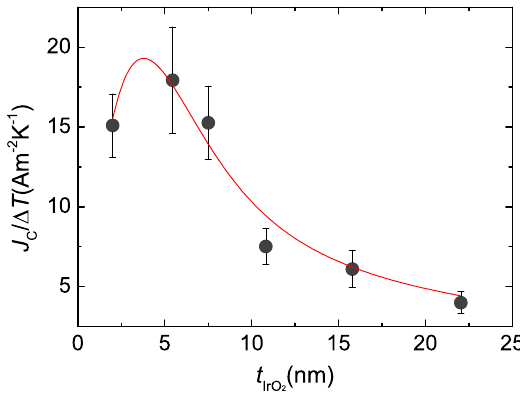
Figure 3. Symbols: ISHE current density normalized by the thermal drop through the sample for every IrO 2 thickness. Line: fit to Equation (6).